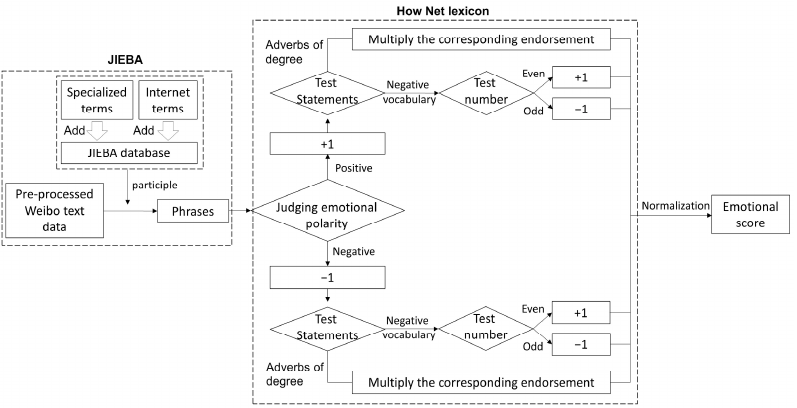
Figure 5. Emotional score algorithm.